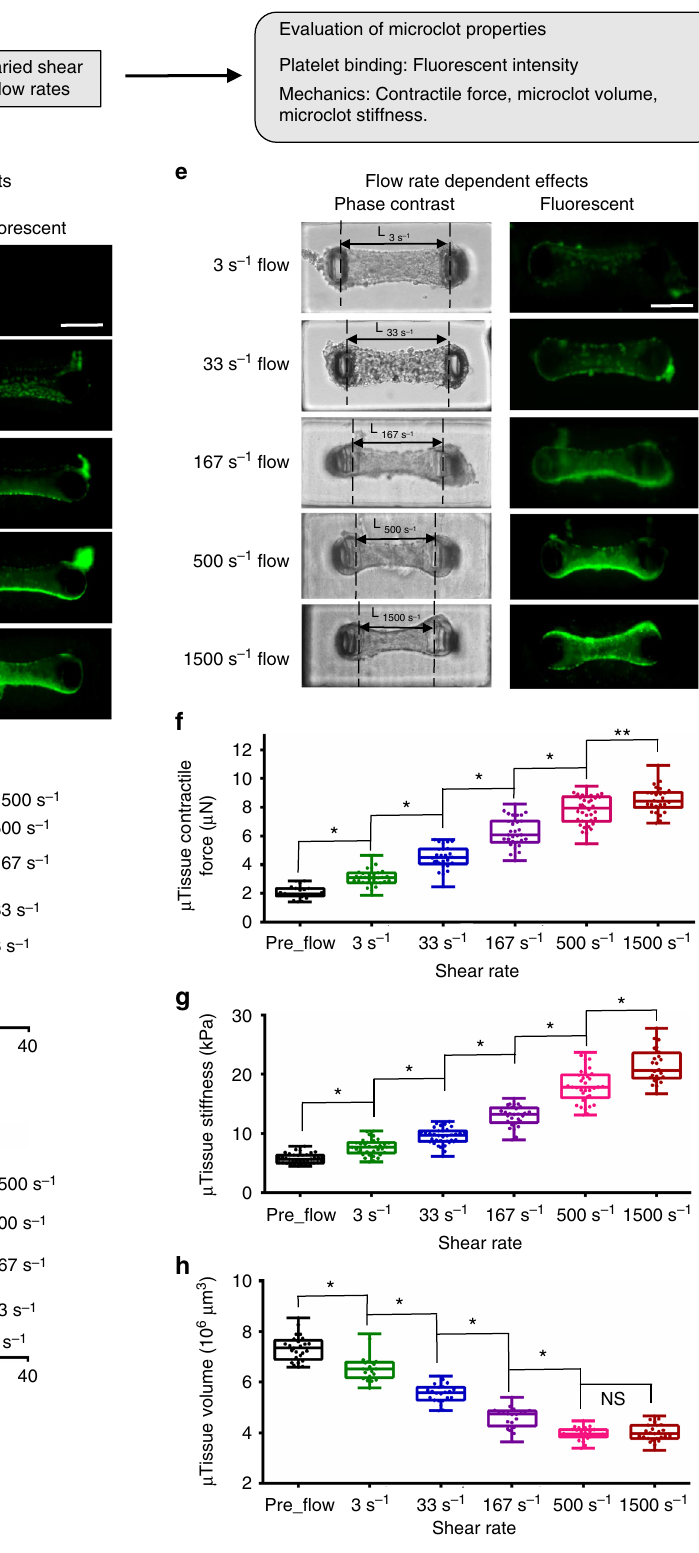
onto the extracellular matrix 36,37 . The colocalization of fi brin and platelet signals in confocal images suggests that platelet adhesion and fi brin formation occur over overlapping time scales (Supplementary Figs. 5 and